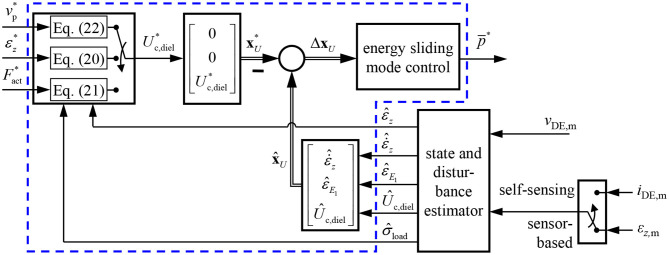
Detailed structure of the controller (blue box in Figure 1) including a feed-forward structure to either control the voltage, strain or force and a three-point controller with hysteresis and adaption of the inner flyback converter control.